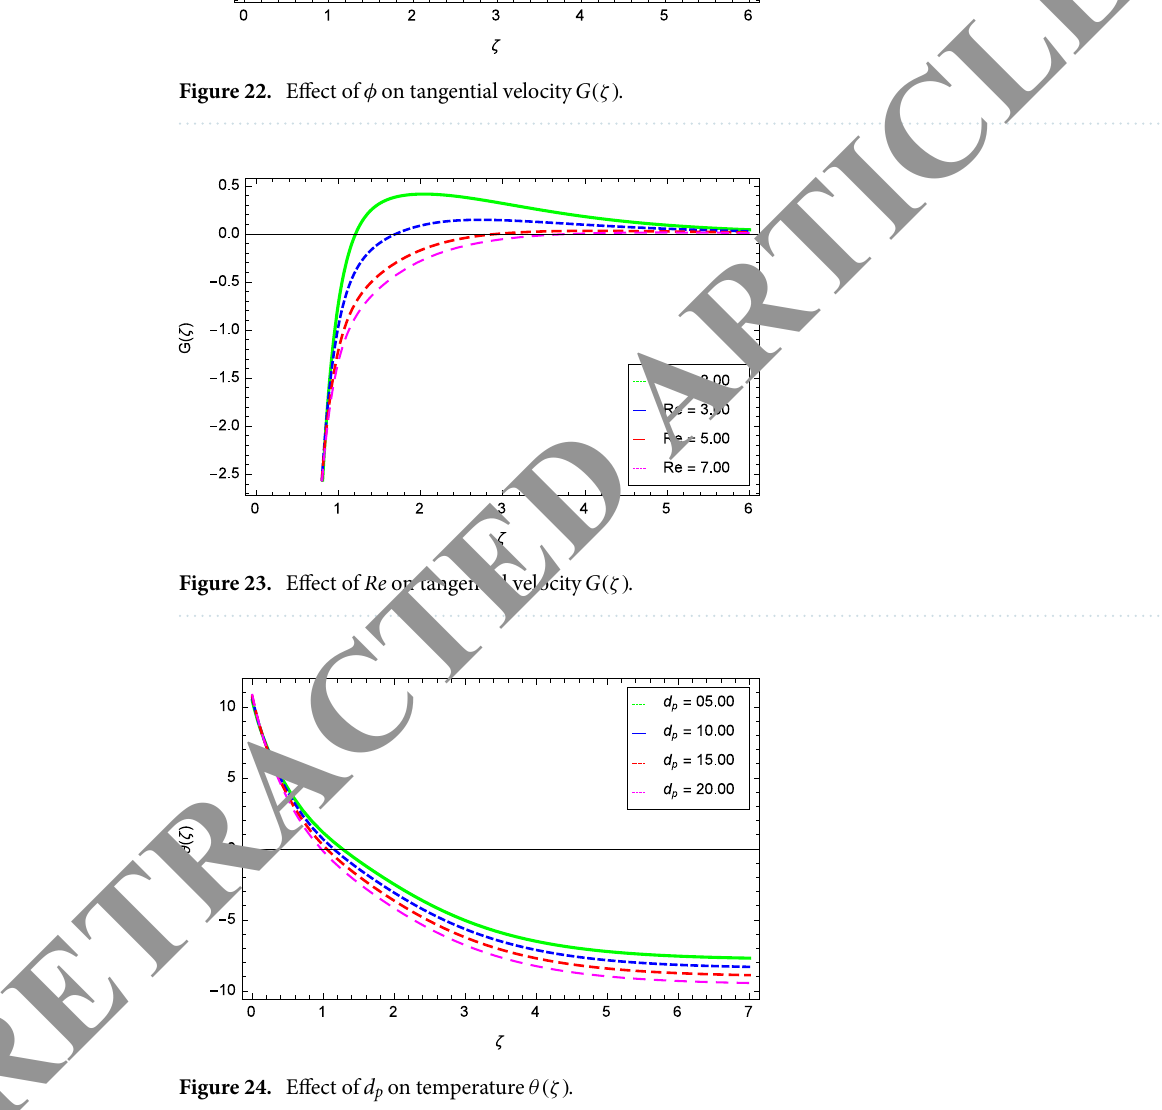
Figure 24. Effect of d p on temperature θ(ζ) .